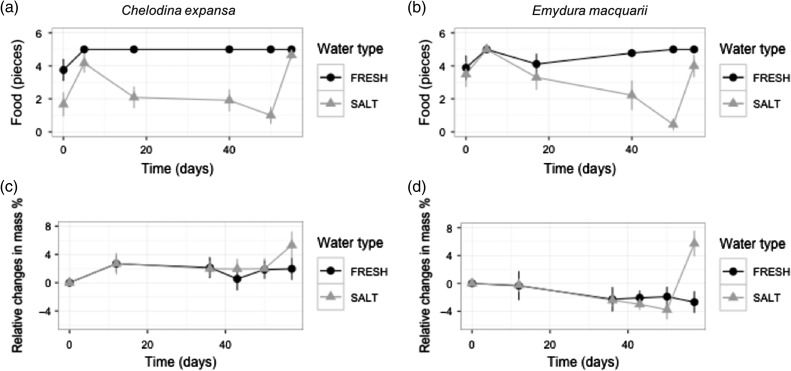
Changes in food consumption and body mass of 24 Chelodina expansa and 19 Emydura macquarii during 50 days in 0‰ water (filled circles) and 15‰ (grey triangles) treatments, followed by 7 days in 0‰ water. Values are expressed as a percentage of values at time zero.